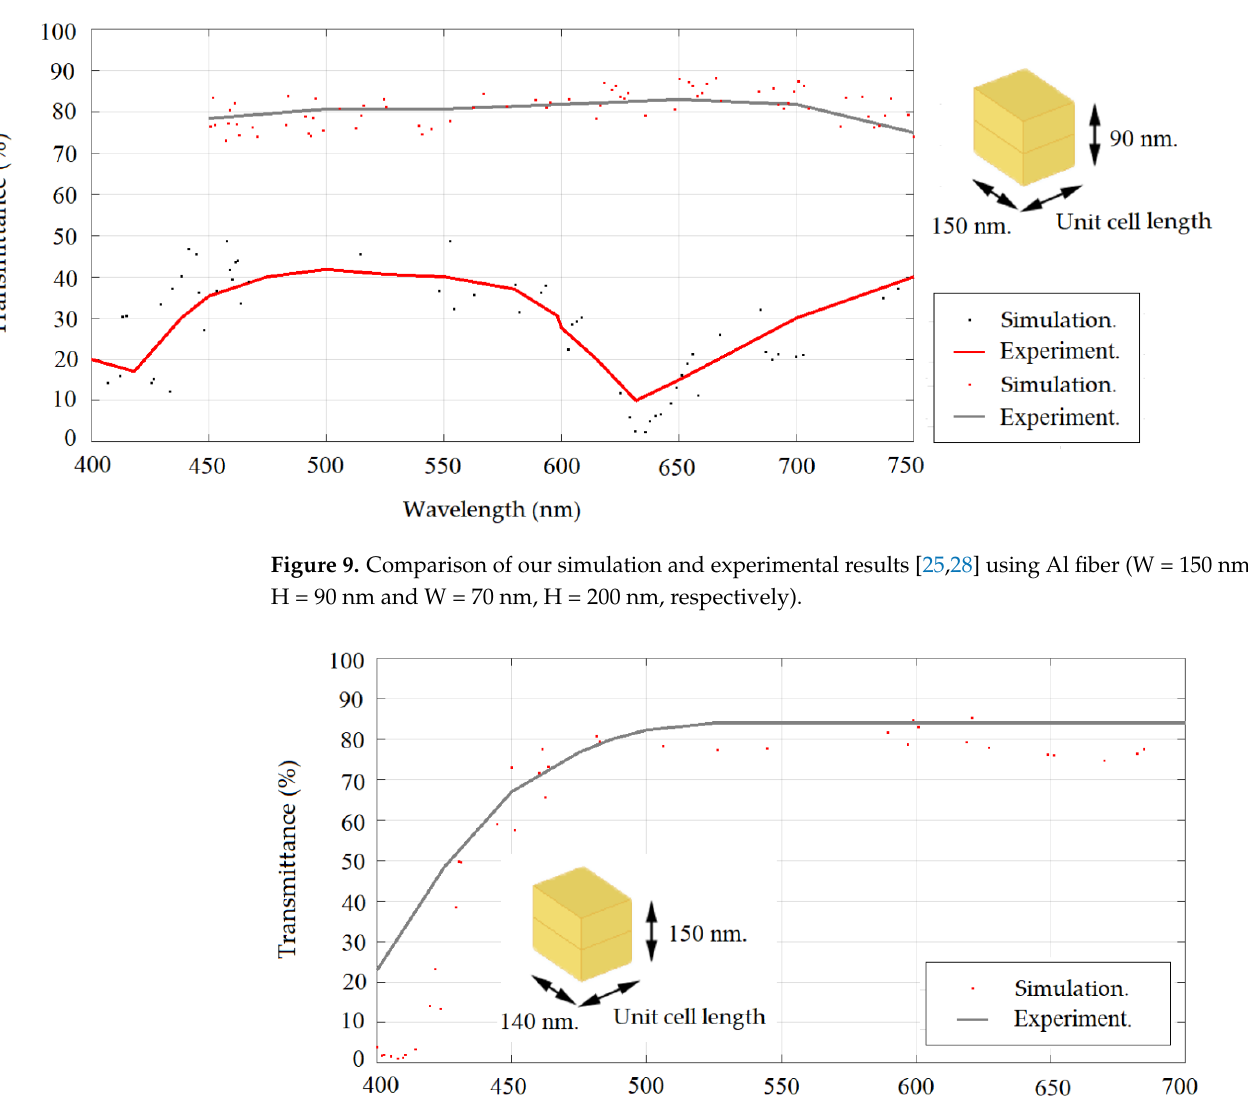
Figure 11. Comparison of our simulation and experimental results [27] using Al fiber (W = 58 nm and H = 241 nm). Table 1. The conclusion of comparison of our simulation with the experimental results. Ref.